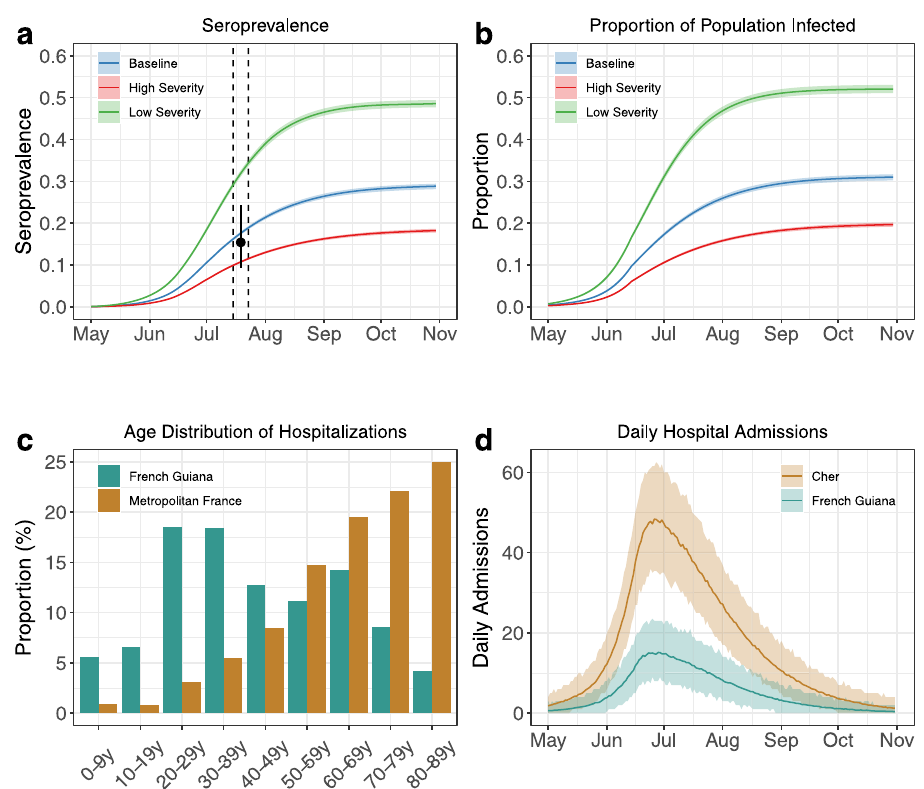
Fig. 4 Analyses made on 25 August 2020. a Projections for the seroprevalence measured with the Euroimmun assay. Solid lines indicate model posterior means while colour areas indicate 95% credible intervals. The black dot and vertical bar indicate seroprevalence estimates from 13 between 15 and 23 July 2020 (dashed lines). b Projections for the proportion infected. Solid lines indicate model posterior means while colour areas indicate 95% credible intervals. c Age distribution of hospitalized cases in Metropolitan France (brown) and French Guiana (green). d Simulated numbers of hospital admissions in the Cher department (Metropolitan France, brown) compared to those obtained for French Guiana (green). Solid lines indicate model posterior means while colour areas indicate 95% credible